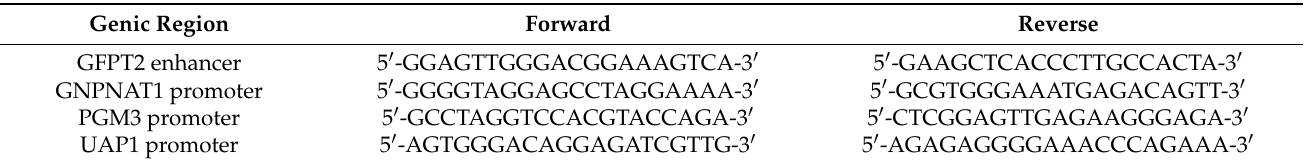
Table 2. Q-gPCR primers for XCHIP